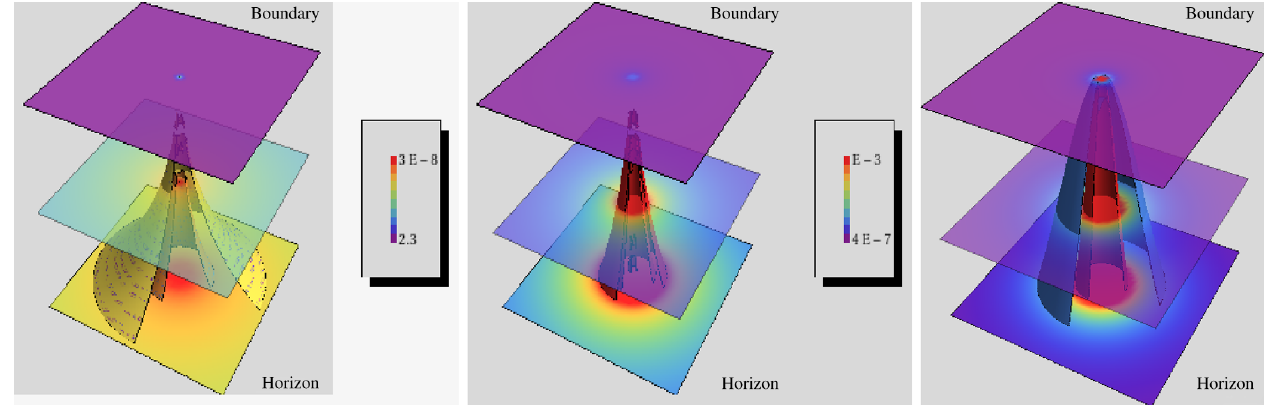
Þ , and (cid:8) FIG. 9. Contour plots for (cid:8) , =ð (cid:8) (left to right) illustrating the vortex structure from the horizon to the boundary. Note 1 2 3 that the ‘‘conical’’ structure is a result of the dependence upon the radial coordinate of the plotted quantities [see Eq. (B6)]. (In contrast to Fig. 8, we are not rescaling here by any powers of r .)